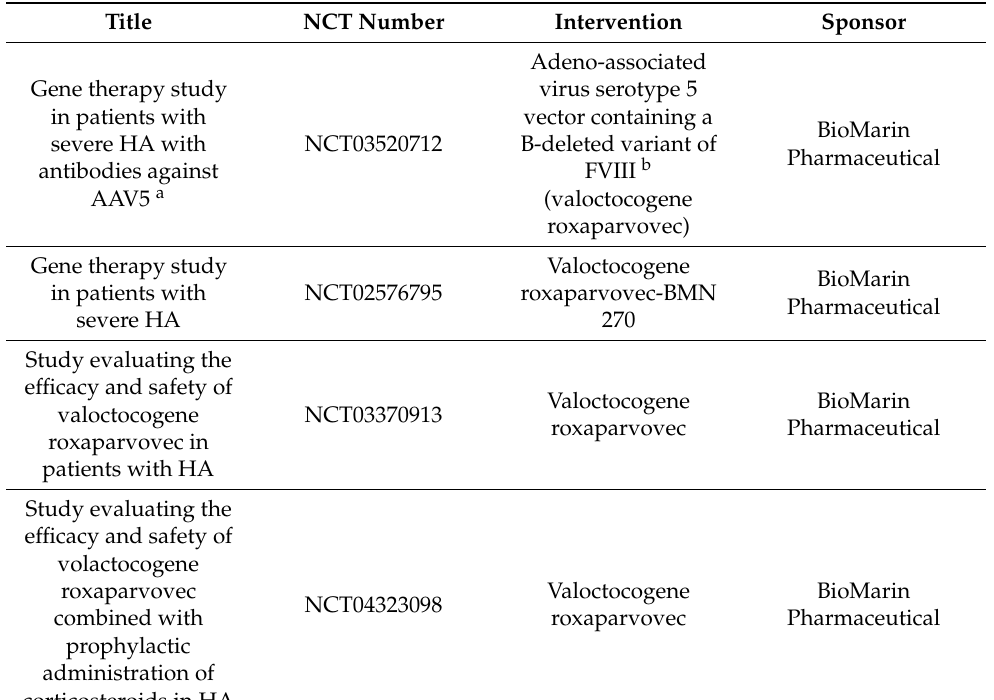
Table 2. Main clinical trials underway in the field of hemophilia A (HA) and hemophilia B